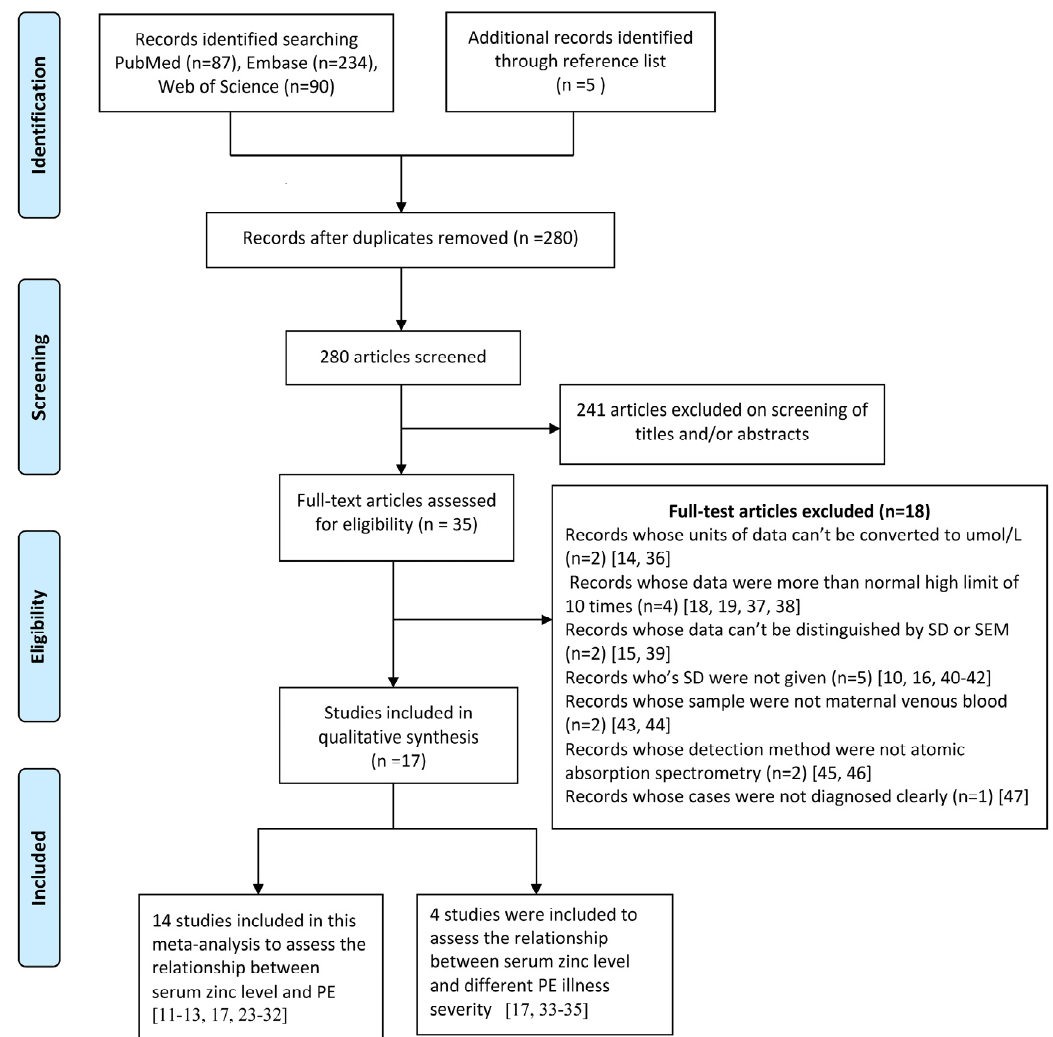
Figure 1. Flow diagram of the literature search.